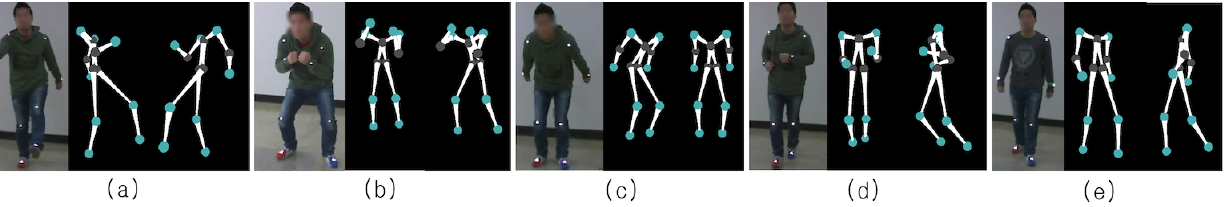
Figure 11. Reconstruction of poses from the CMUmotion capture database. ( a ) March. ( b ) Guard. ( c ) Jump. ( d ) Run. ( e )